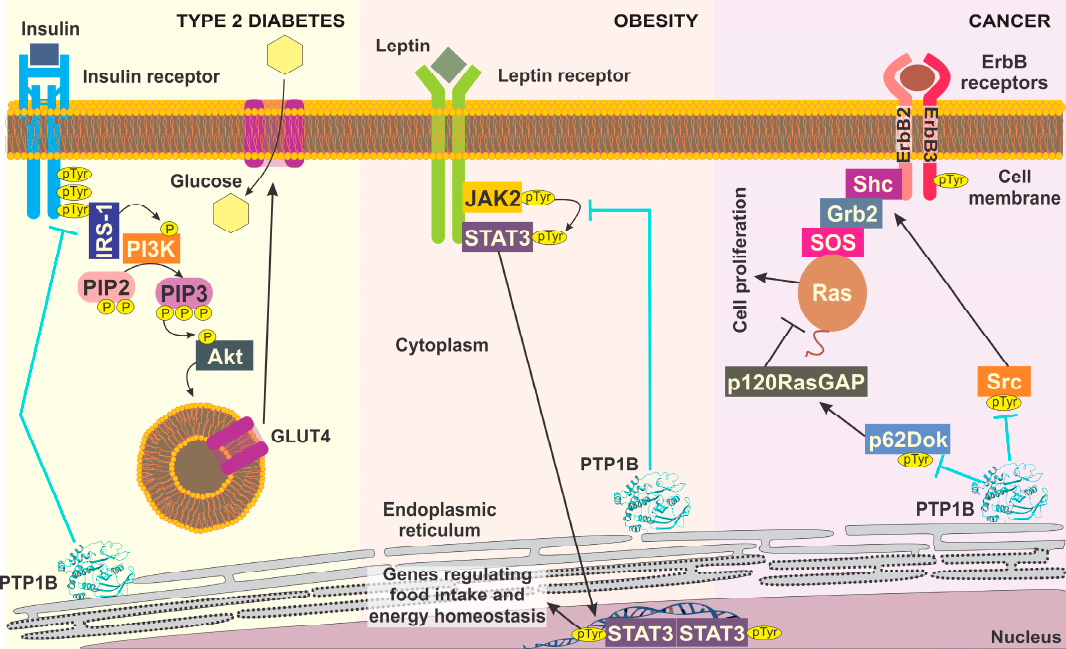
Figure 1. Role of PTP1B in the signal pathway for type 2 diabetes, obesity, and